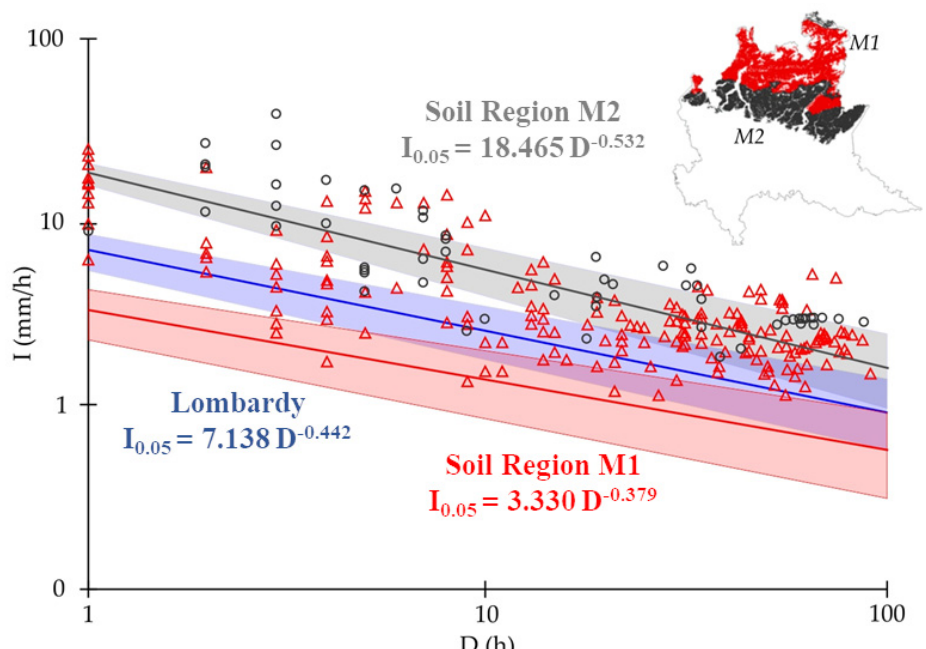
Figure 8. Rainfall intensity–rainfall duration (ID) thresholds for the whole data set and for the two soil regions (M1 and M2) (see Table 5. Colored lines are 5% power law thresholds. Shaded areas between dashed lines show 95% confidence intervals of the threshold curves.